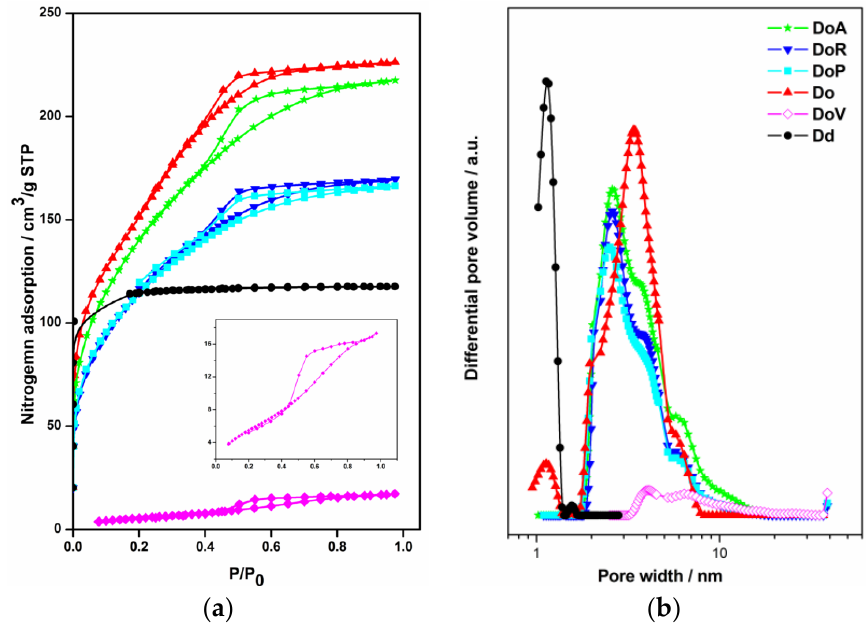
Figure 4. Adsorption-desorption isotherms for xerogels ( a ) and the corresponding pore size distributions ( b ) obtained by the NLDFT method. Table 3. Texture parameters of xerogels.